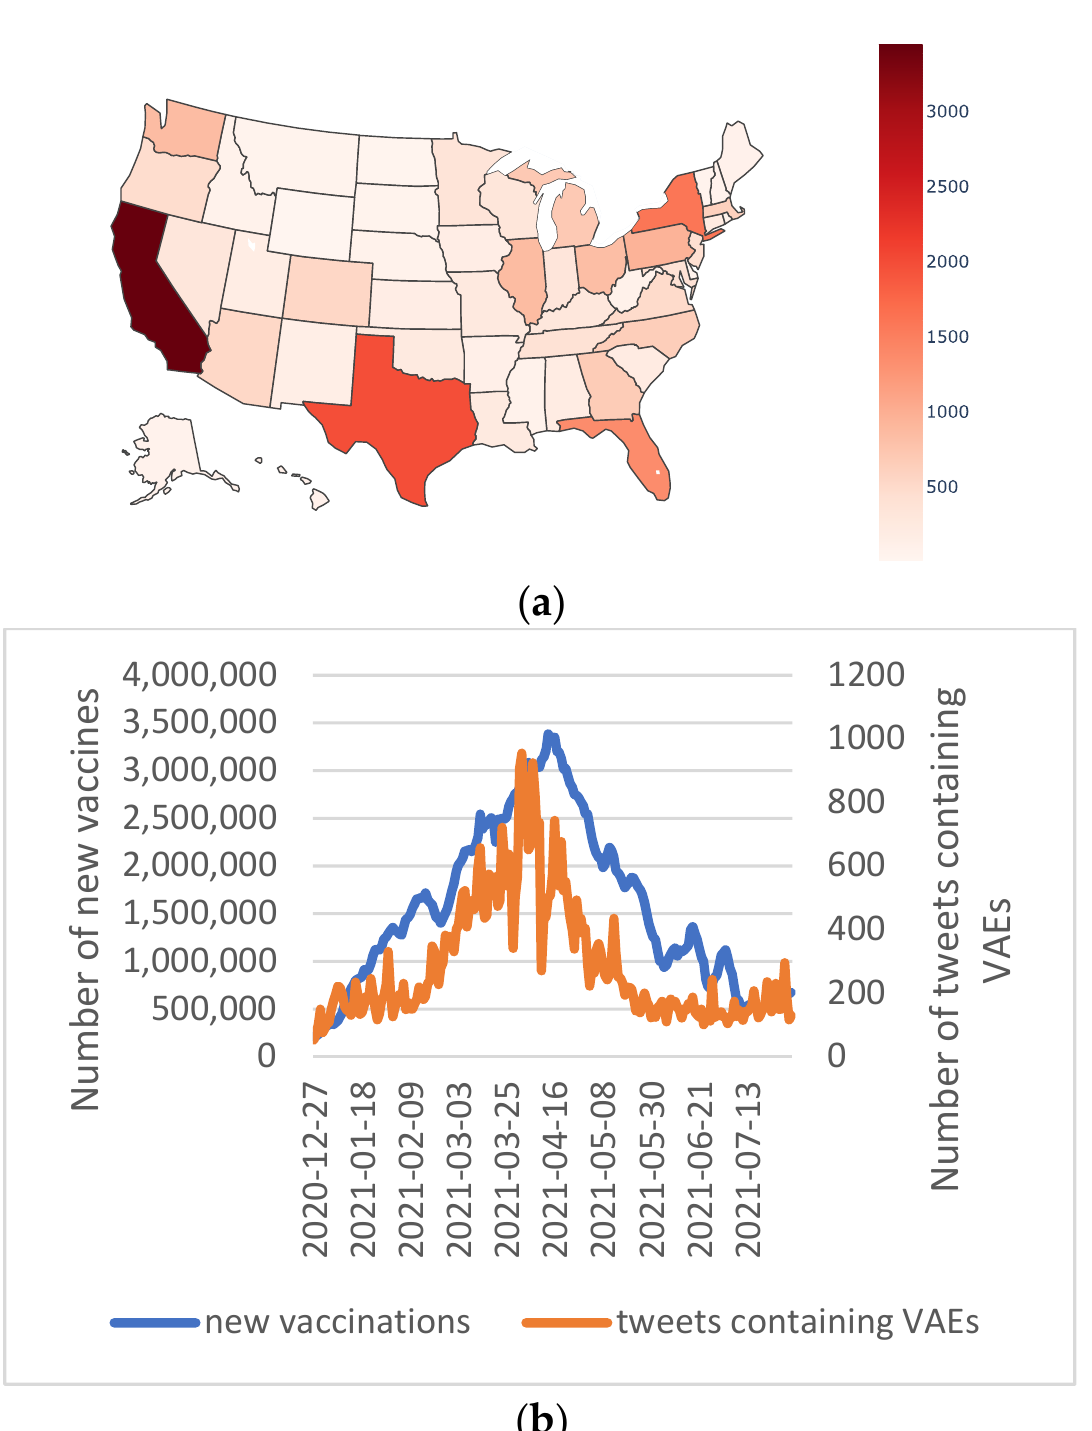
Figure 3. ( a ) Distribution of tweets containing self-experienced COVID-19 VAEs by US states. ( b ) VAE tweet temporal trends and new vaccination numbers in the United States (new vaccination numbers from Ritchie